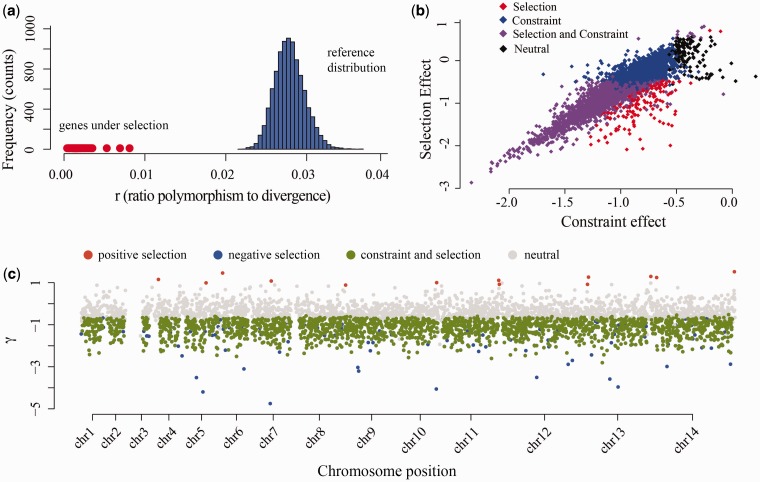
Identification of genes under selection. (a) Results of the modified HKA test for the identification of genes with decreased polymorphism to divergence ratio (r): in blue the reference distribution generated from 100 neutral loci is represented, and in red dots are represented the genes for which a significant difference has been identified. (b) General results from the Bayesian modified MK test (SnIPRE test): each diamond correspond to the inferred values of constraint (x axis, in the model) and the selection effect (y axis, βND+βNDG in the model) for each loci. Genes under positive selection are expected to have a significant positive selection effect (positive values in the y axis) and reduced constraint (larger values in x axis). There is a high prevalence of genes under strong negative selection and constraint (purple diamonds). All sites under selection (positive or negative) with no significant constraint are represented in red. (c) The distribution genome wide of the selection effects estimated per loci under SnIPRE. The red dots correspond to positively selected loci.